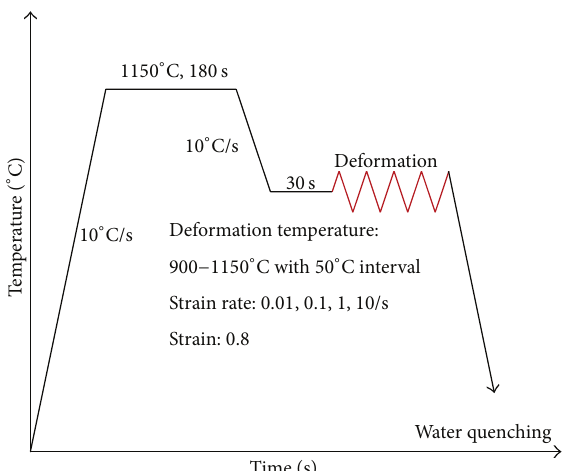
Figure 1: Experimental procedure for hot compression tests.